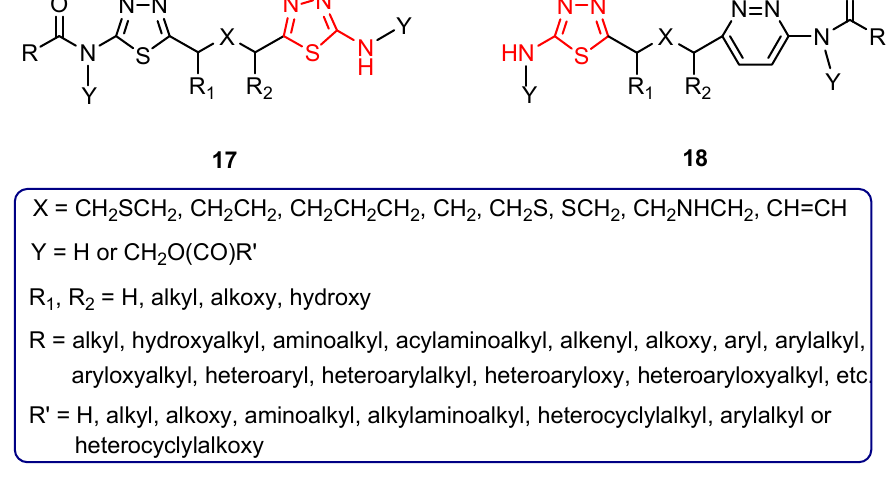
Figure 4. The general formula of glutaminase inhibitors 17 and 18.